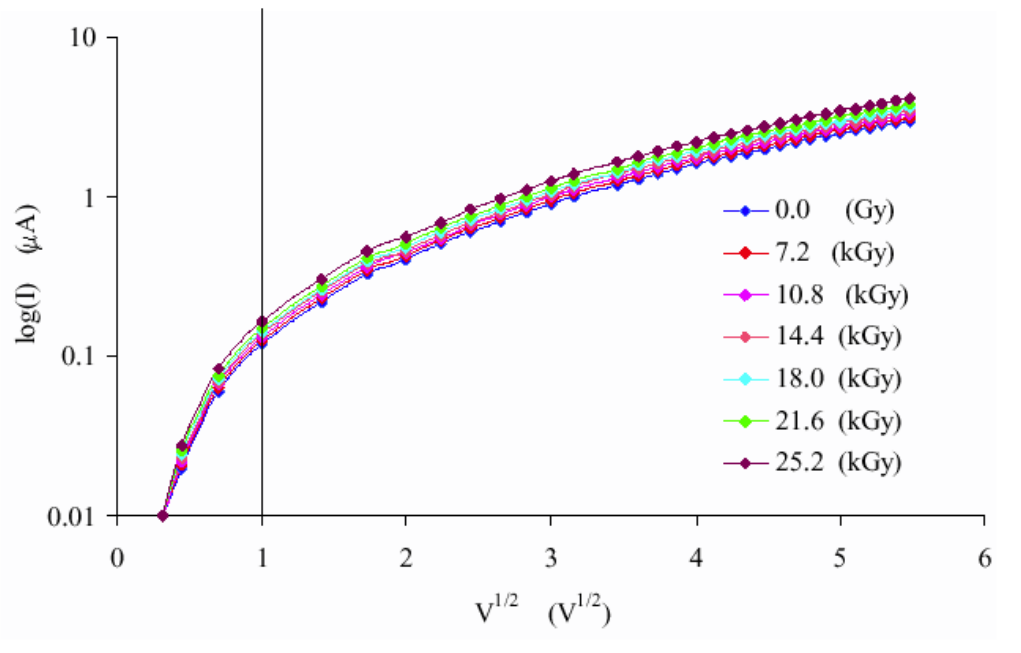
Figure 7. log(I) versus V 1/4 for MnPc thick film: all films show electrode-limited at low voltages and bulk-limited at high voltages.